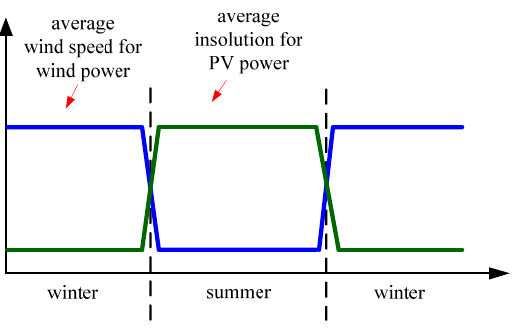
Figure 1. Energy curves of PV power and wind power for season alteration.